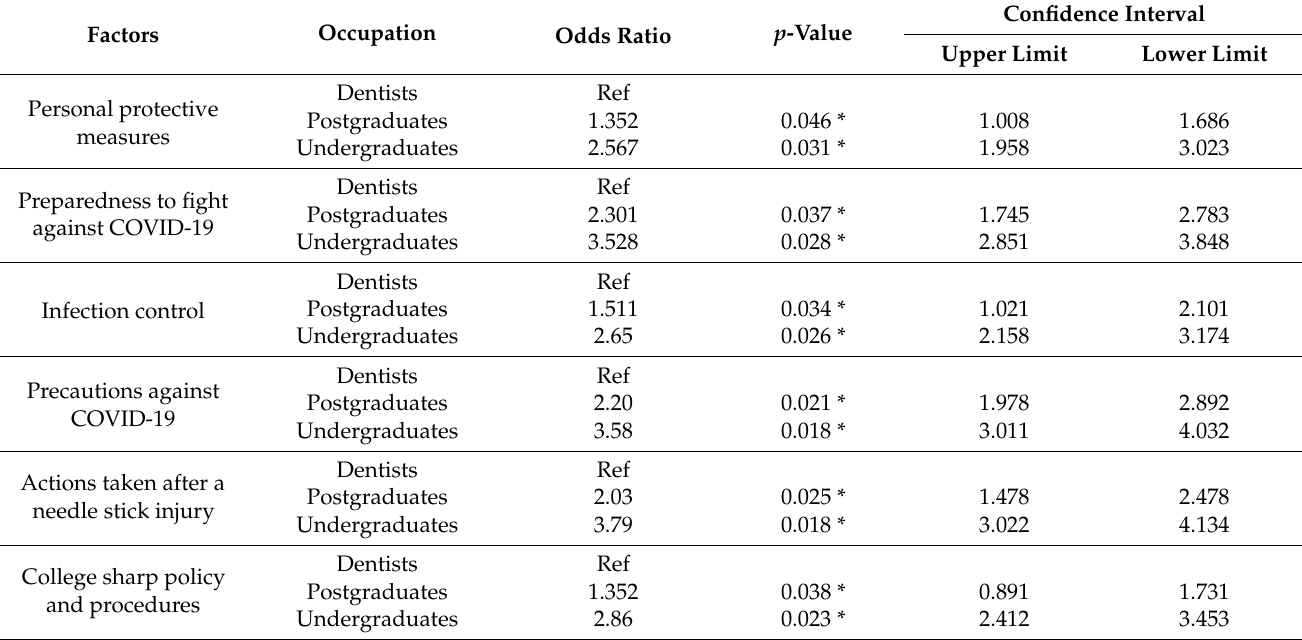
Univariate logistic regression (* denotes statistically significant